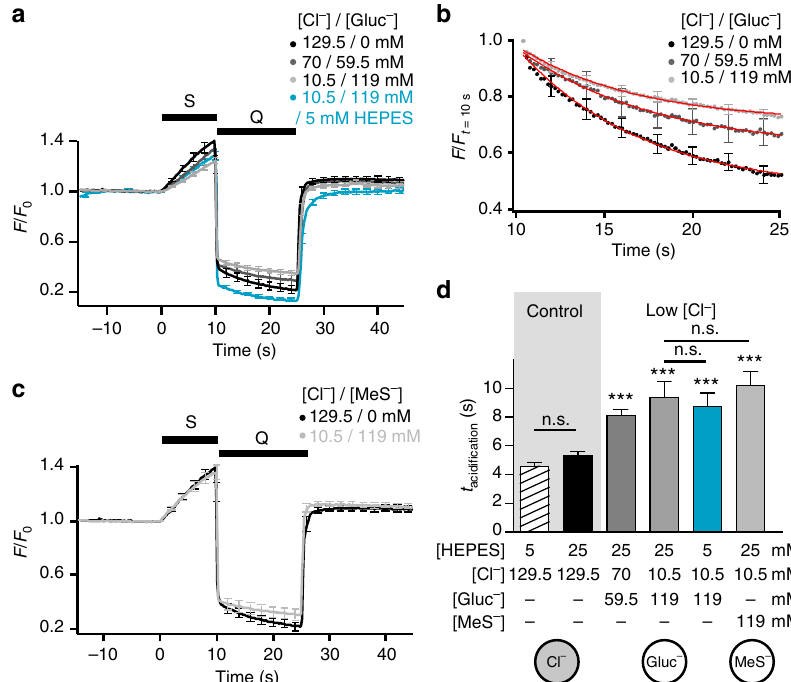
Fig. 7 Vesicular chloride controls the rate of acidi fi cation. a – c Rapid acid quench (Q) of surface SpH fl uorescence following stimulation (S, 200 APs at 20 Hz) in presence of different [Cl − ]/[Gluc − ] ( a , b ) or [Cl − ]/[MeS − ] ( c ) with 25 mM HEPES unless otherwise stated ( n = 8 – 17). b The fl uorescence from SpH shown in a was normalized to the fi rst data point measured during post-stimulus acid quench. Red curves: single exponential fi ts of the SpH fl uorescence during the quench. d Bar graph of acidi fi cation time constants from experiments in a and c . 25 mM HEPES: P = 0.0676 compared with 5 mM HEPES; 70 mM Cl − /59.5 mM Gluc − : P < 0.0001 compared with 25 mM HEPES; 10.5 mM Cl − /119 mM Gluc − : P = 0.0001 compared with 25 mM HEPES; 5 mM HEPES/ 10.5 mM Cl − /119 mM Gluc − : P < 0.0001 compared with 5 mM HEPES, P = 0.6936 compared with 25 mM HEPES/10.5 mM Cl − /119 mM Gluc − ; 10.5 mM Cl − /119 mM MeS − : P < 0.0001 compared with 25 mM HEPES, P = 0.5703 compared with 10.5 mM Cl − /119 mM Gluc − ; analysed with two-tailed unpaired t - test. Sketches below show the main anion present in SV. Traces represent responses of glutamatergic boutons only. n.s. non signi fi cant; ***signi fi cant changes. Error bars represent s.e.m. They are shown every tenth point (2 s) for better initial H + pumping rates from the acidi fi cation rate constants. Upon recycling, the pH of SV decreases from 7.3 to 5.5. Within τ